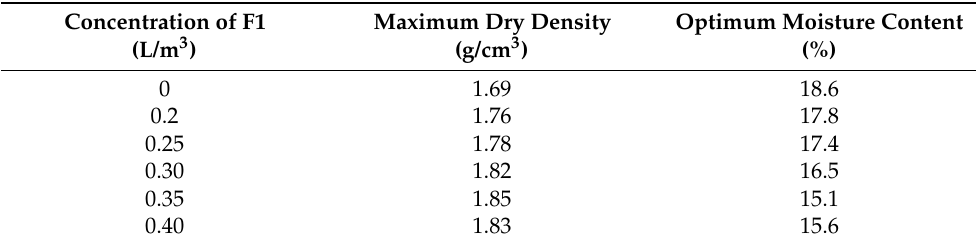
Figure 4. Moisture–density curve. Table 2. Compaction test